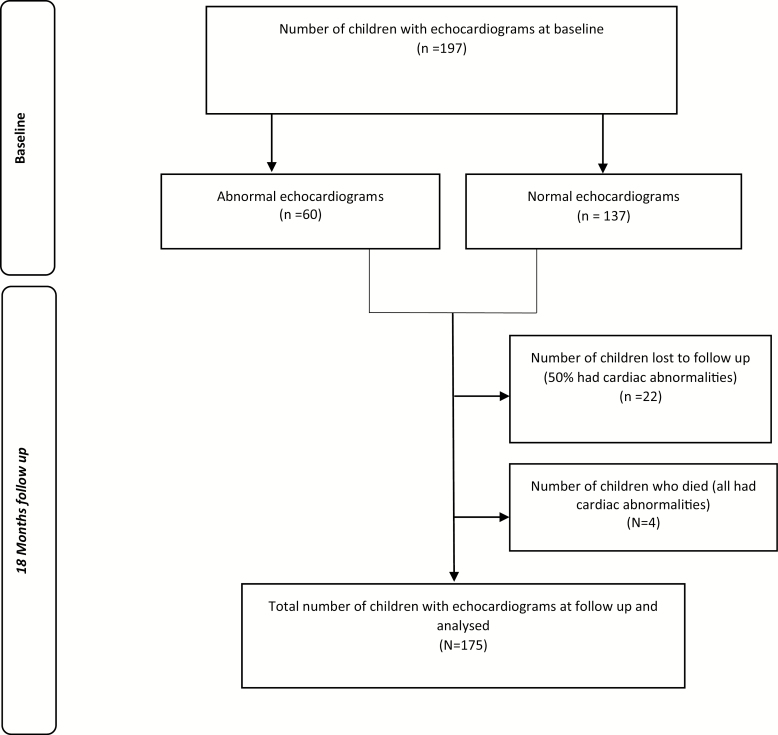
Flow chart for participant recruitment and follow-up.